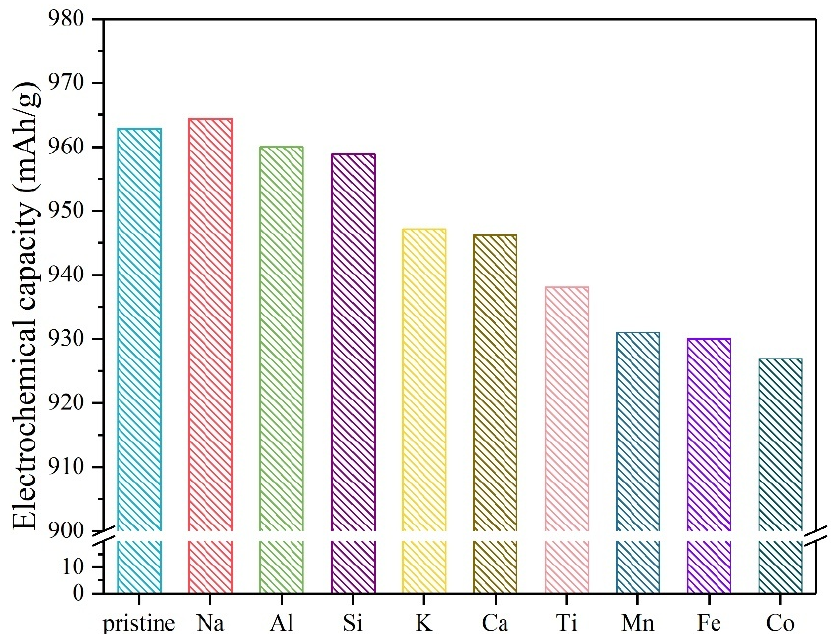
Figure 2. The specific capacity comparison of pristine and various doped Mg 2 NiH 4 .